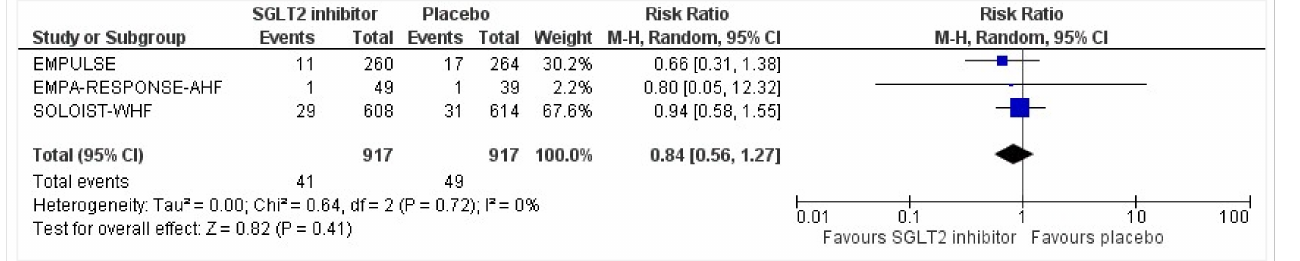
Figure 12. Forest plot for the total number of patients who had a urinary tract infection as a serious adverse event in either group [25–27].